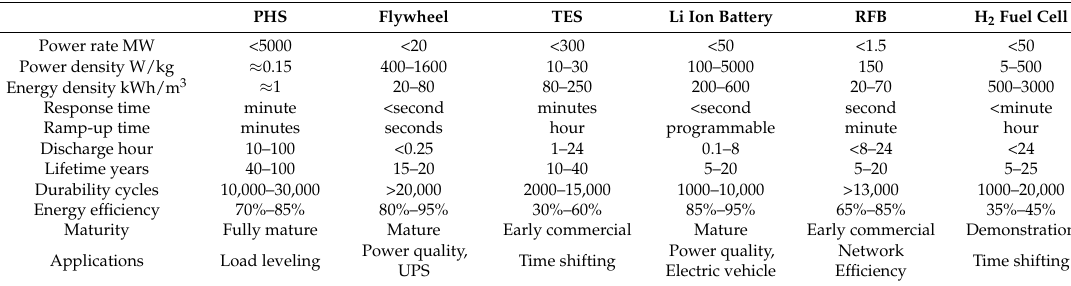
Figure 1. Architecture of a large electric grid, including successive voltage level and transport and distribution power sub-grids, interconnected by transformer stations. Distinct typologies of generation plants, consumers and storage plants are branched at each level of voltage and power. Table 1. Some tested and performing technical solutions to provide energy storage to service the electric grid (References [21–24]).